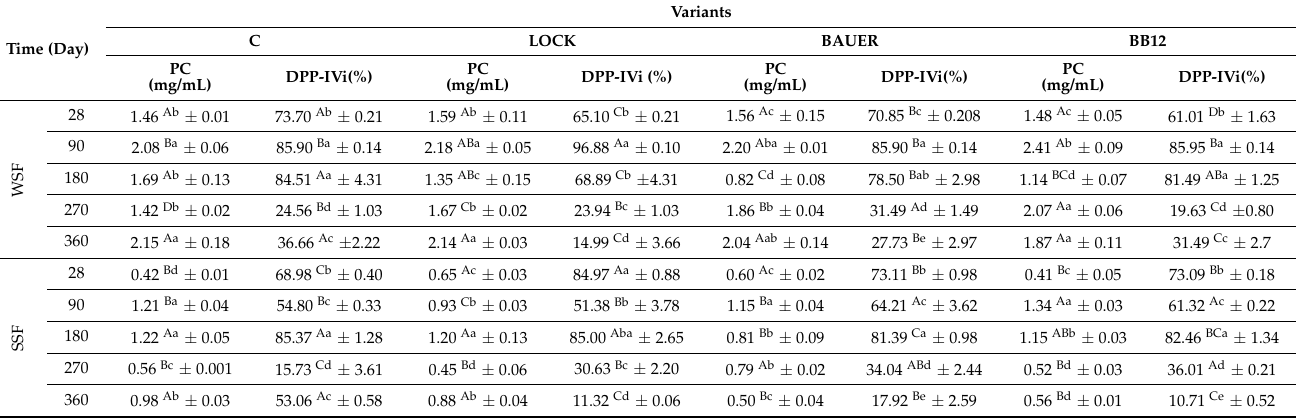
Table 2. Dipeptidyl peptidase IV inhibiting activity (DPP-IVi; %) and peptides concentration (PC, mg/mL) of intact proteins (extracts) of dry-cured pork